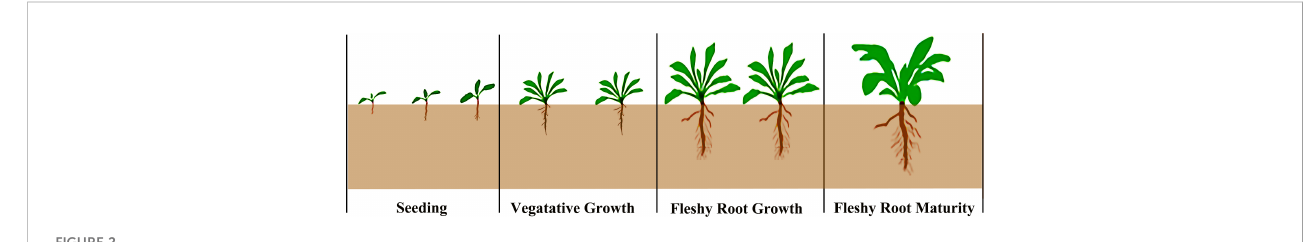
FIGURE 2 Schematic diagram of the growth period division of woad.